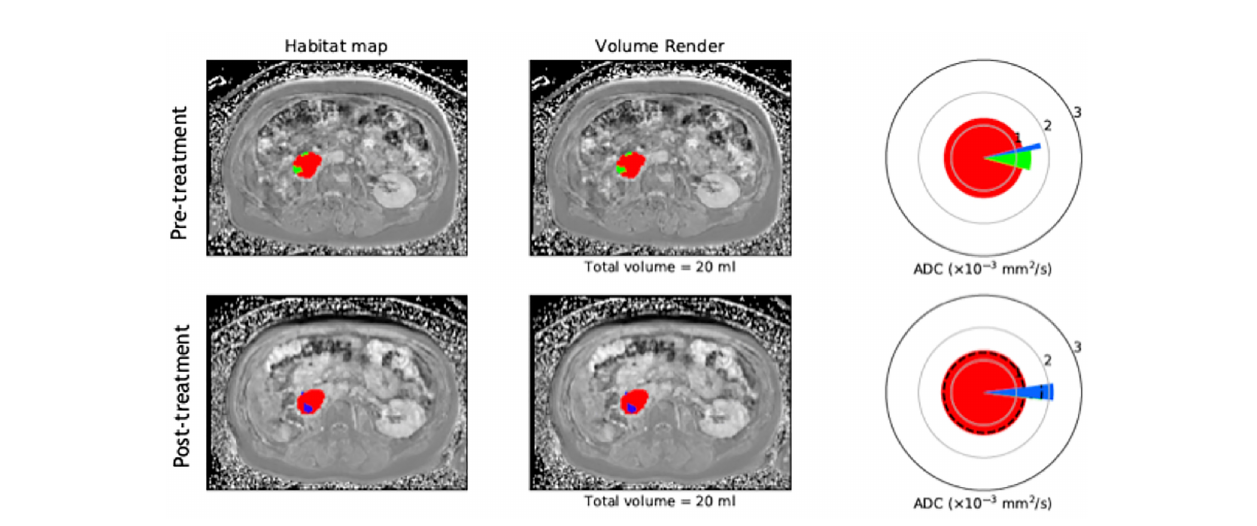
FIGURE 3 | Example of habitat imaging as demonstrated by a supplementary fi gure provided by Blackedge et al. (21). Axial MRI scan taken pre and post-radiotherapy in a patient with a retropentoneal STS tumour. Habitat maps are overlaid on MRI scans acquired for this patient and volume renders shown. The different colours within the mass on MRI scans represent the different sub compartments assigned according to the qMRI parameters EF. FF and ADC. Tissue sub compartments with high ADC and low FF are represented in blue and may suggest necrotic or cystic tissue, low ADC and high EF in red and suggest cellular vascular tissue, and low ADC and low EF in green and suggest poorly vasculansed tissue. Spie charts show the average ADC for each tissue sub compartment as the illustrated radius of each segment, whilst the angular proportion represents the proportional volume of habitat class. Pre and post-treatment, the colours within the mass are shown to change, with loss of the green sub compartment (poorly vasculansed tissue) and increase in the blue sub compartment (necrotic/cystic tissue), signifying a change in tissue characteristics following therapy and possible response even when overall volume is unchanged. (Figure adapted from